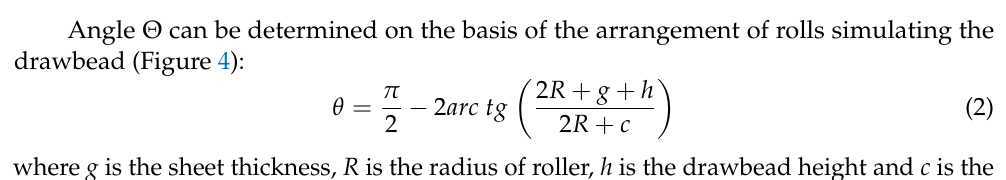
where g is the sheet thickness, R is the radius of roller, h is the drawbead height and c is the side